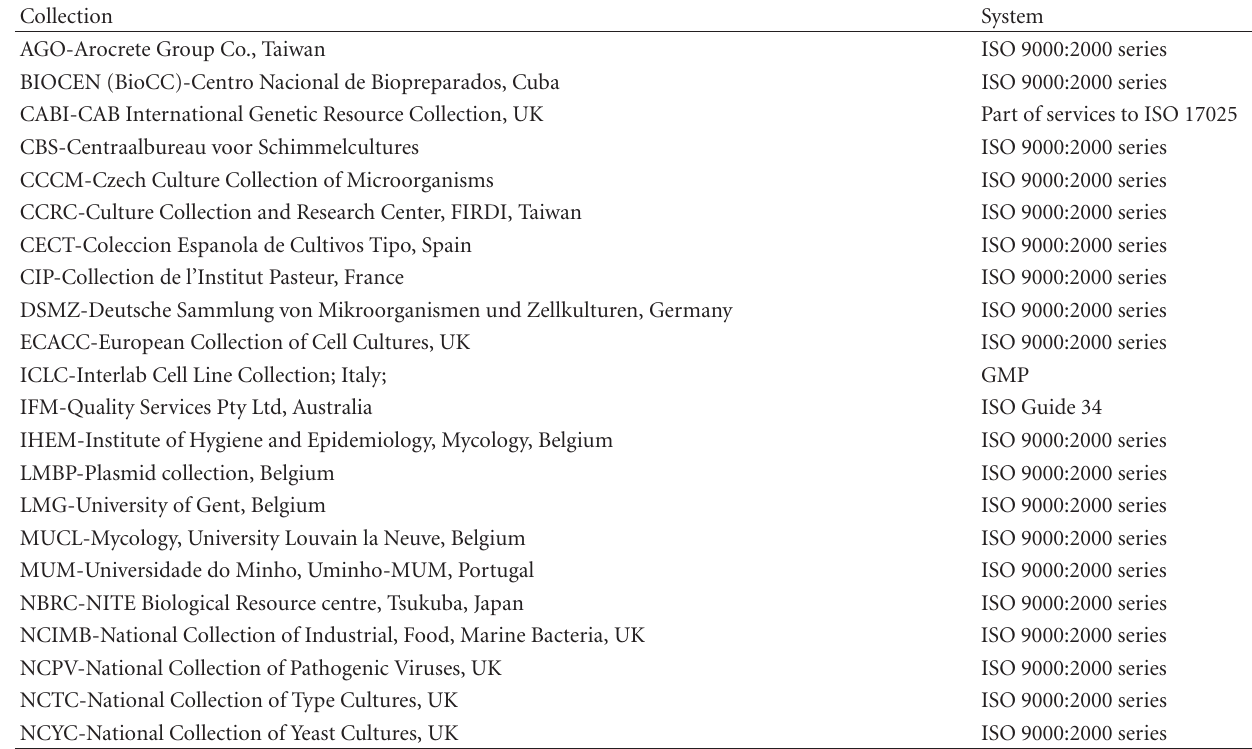
Table 1: Collections operating independent third party assessed certification or accreditation quality management